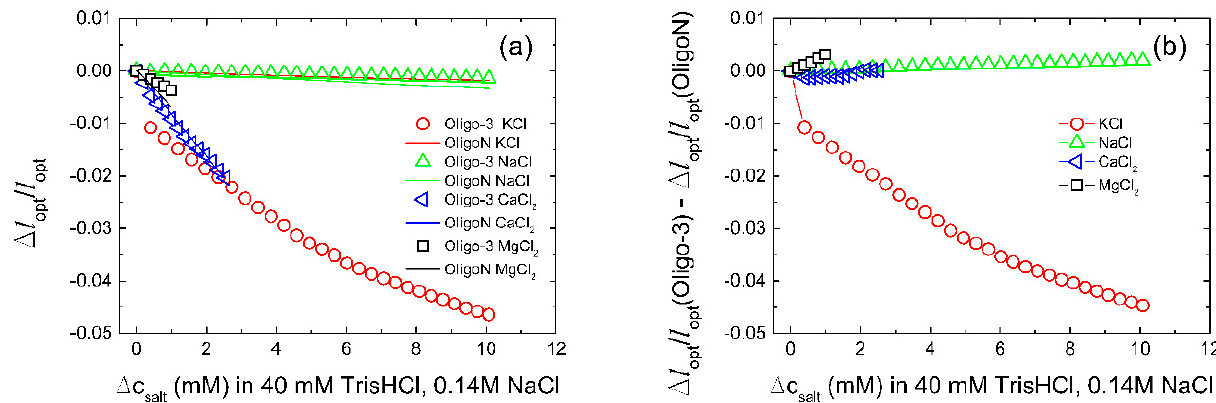
Figure 4. Sensor selectivity. ( a ) Change in the optical length of the sensor and control gels as a function of K + , Na + , Ca 2+ , Mg 2+ ions added to at least upper physiological level concentration. The experiments were carried out in Tris-HCl buffer (50 mM, pH 7.4, 140 mM NaCl) at room temperature. ( b ) Selectivity of the oligo-3 biosensor relative to random oligoN-co-AAm hydrogel sensors for the various salts KCl, NaCl, CaCl 2 , and MgCl 2 . The selectivity is estimated as the difference in the relative change of the optical lengths versus salt concentrations for the oligo-3-co-AAm and random oligoN-co-AAm.